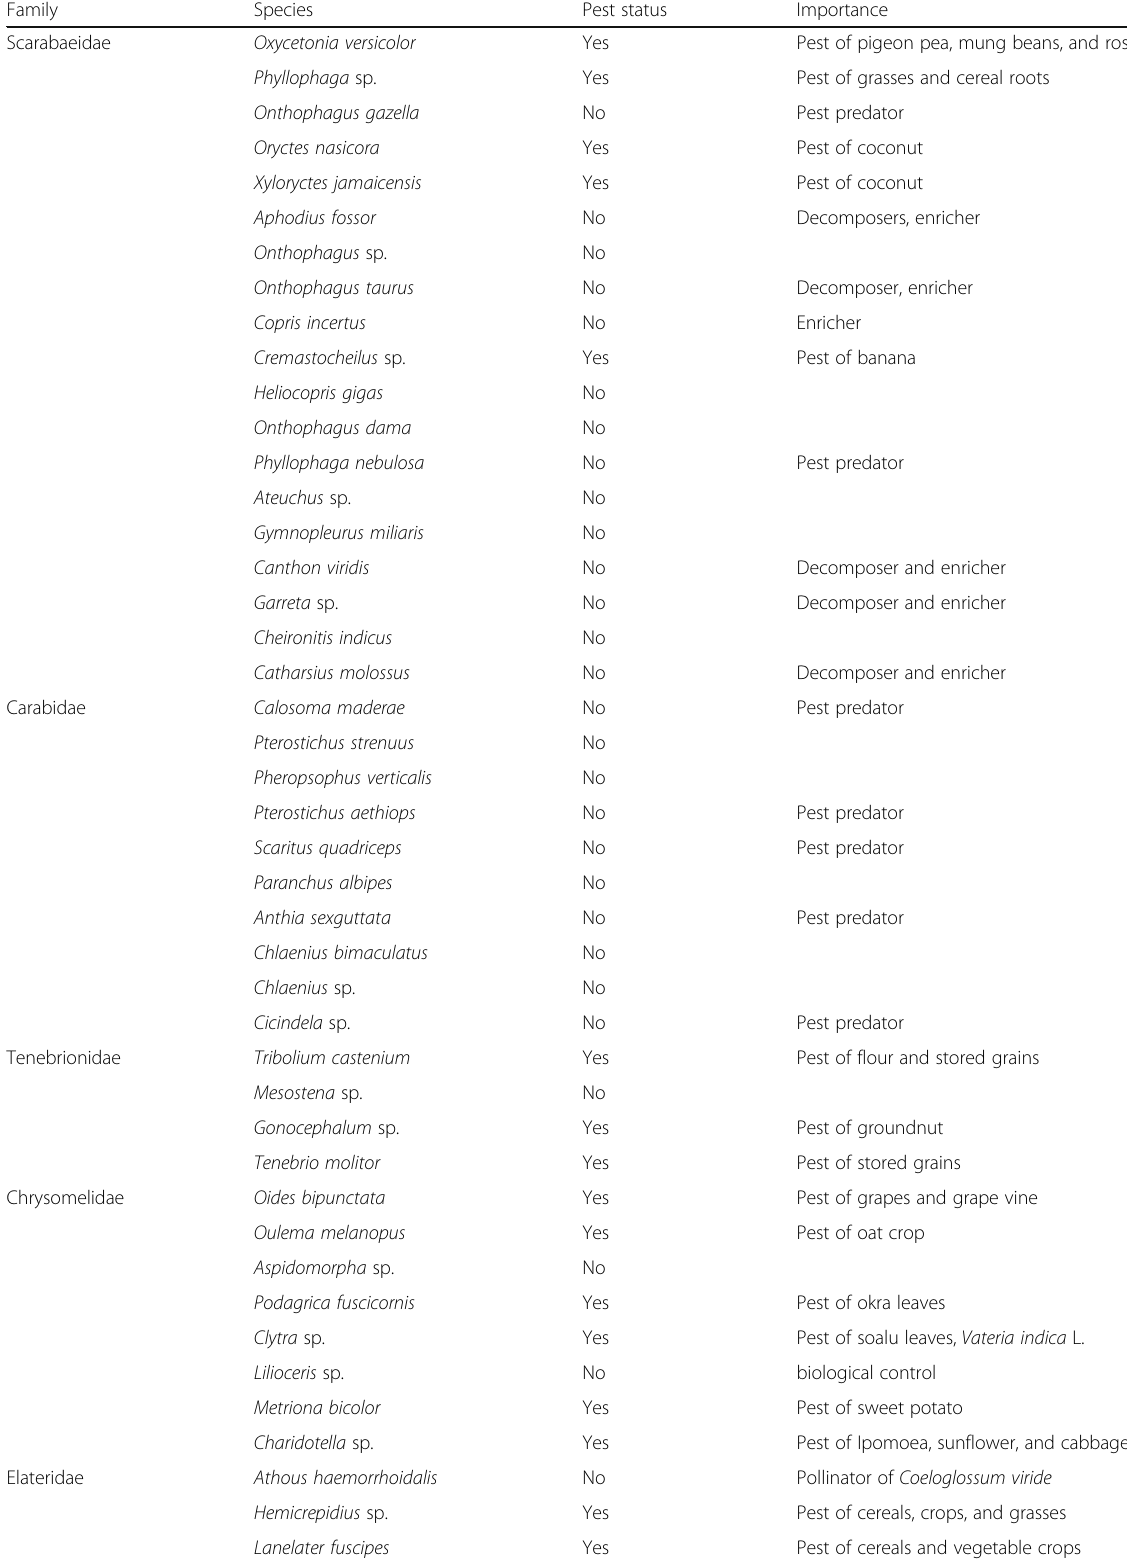
Table 1 Annotated checklist and pest status of Coleoptera of Vadodara, Gujarat,